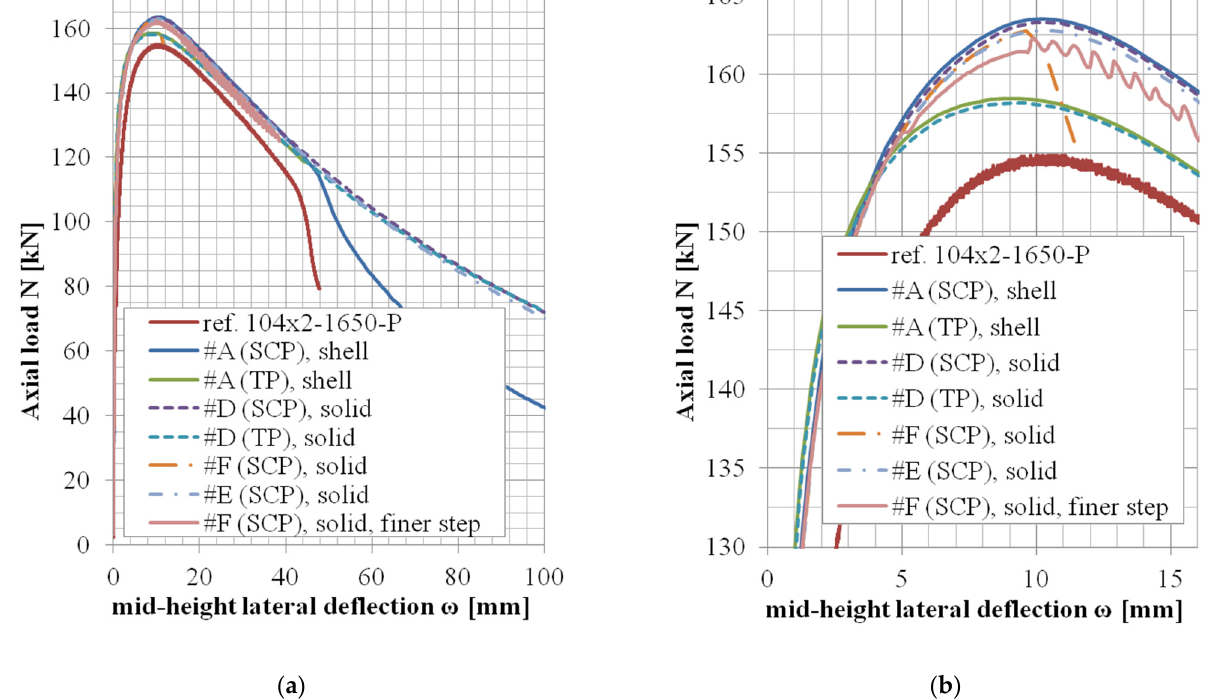
Figure 11. Experimental and FE loads vs. midheight lateral deflection curves of 104 × 2-1650-P [38]: ( a ) whole*; ( b ) zoom.